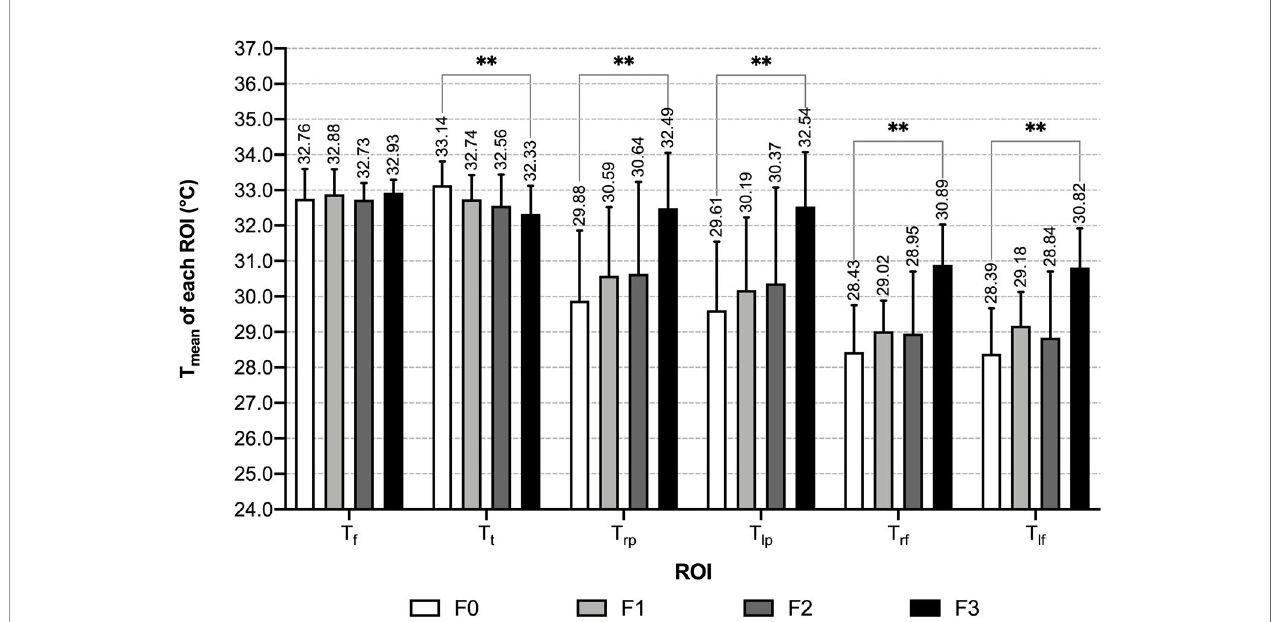
FIGURE 7 | T mean of each ROI of female groups - grouped by ROI. **: P <